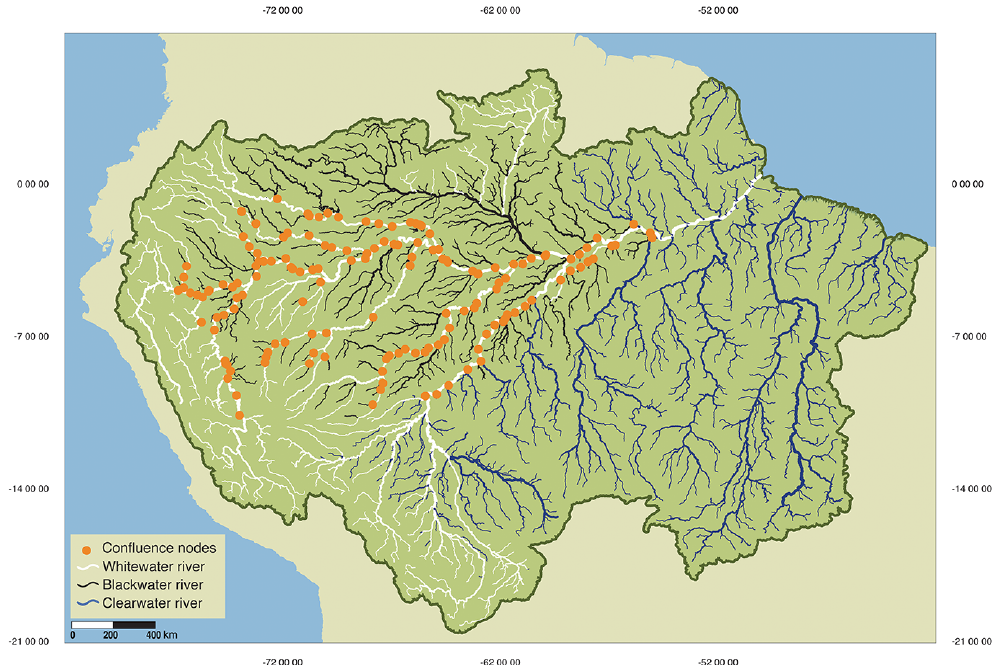
Figure 5. Cartographic representation of important confluence areas for spawning, derived from the intersection of spawning nodes and sub-basins or main stem drainages important for commercial